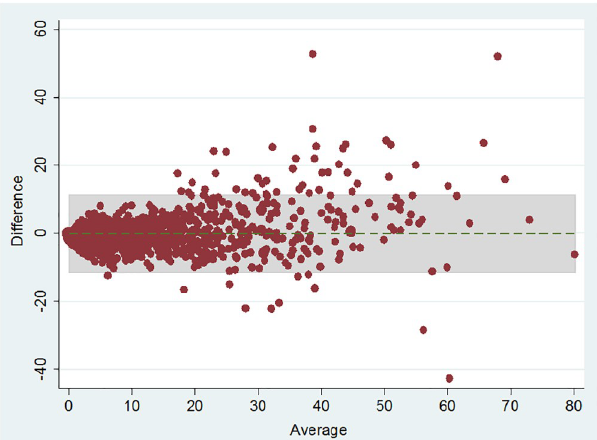
Fig 1. Bland-Altman plot of apnea-hypopnea index (AHI) from portable device versus oxygen desaturation index (ODI) from simultaneously recorded oximetry (N = 1,218). The vertical axis represents difference of AHI and ODI and horizontal axis represents average of AHI and ODI. Shaded area represents limits of agreement ( ± 2 SD) while dotted line represents mean difference.